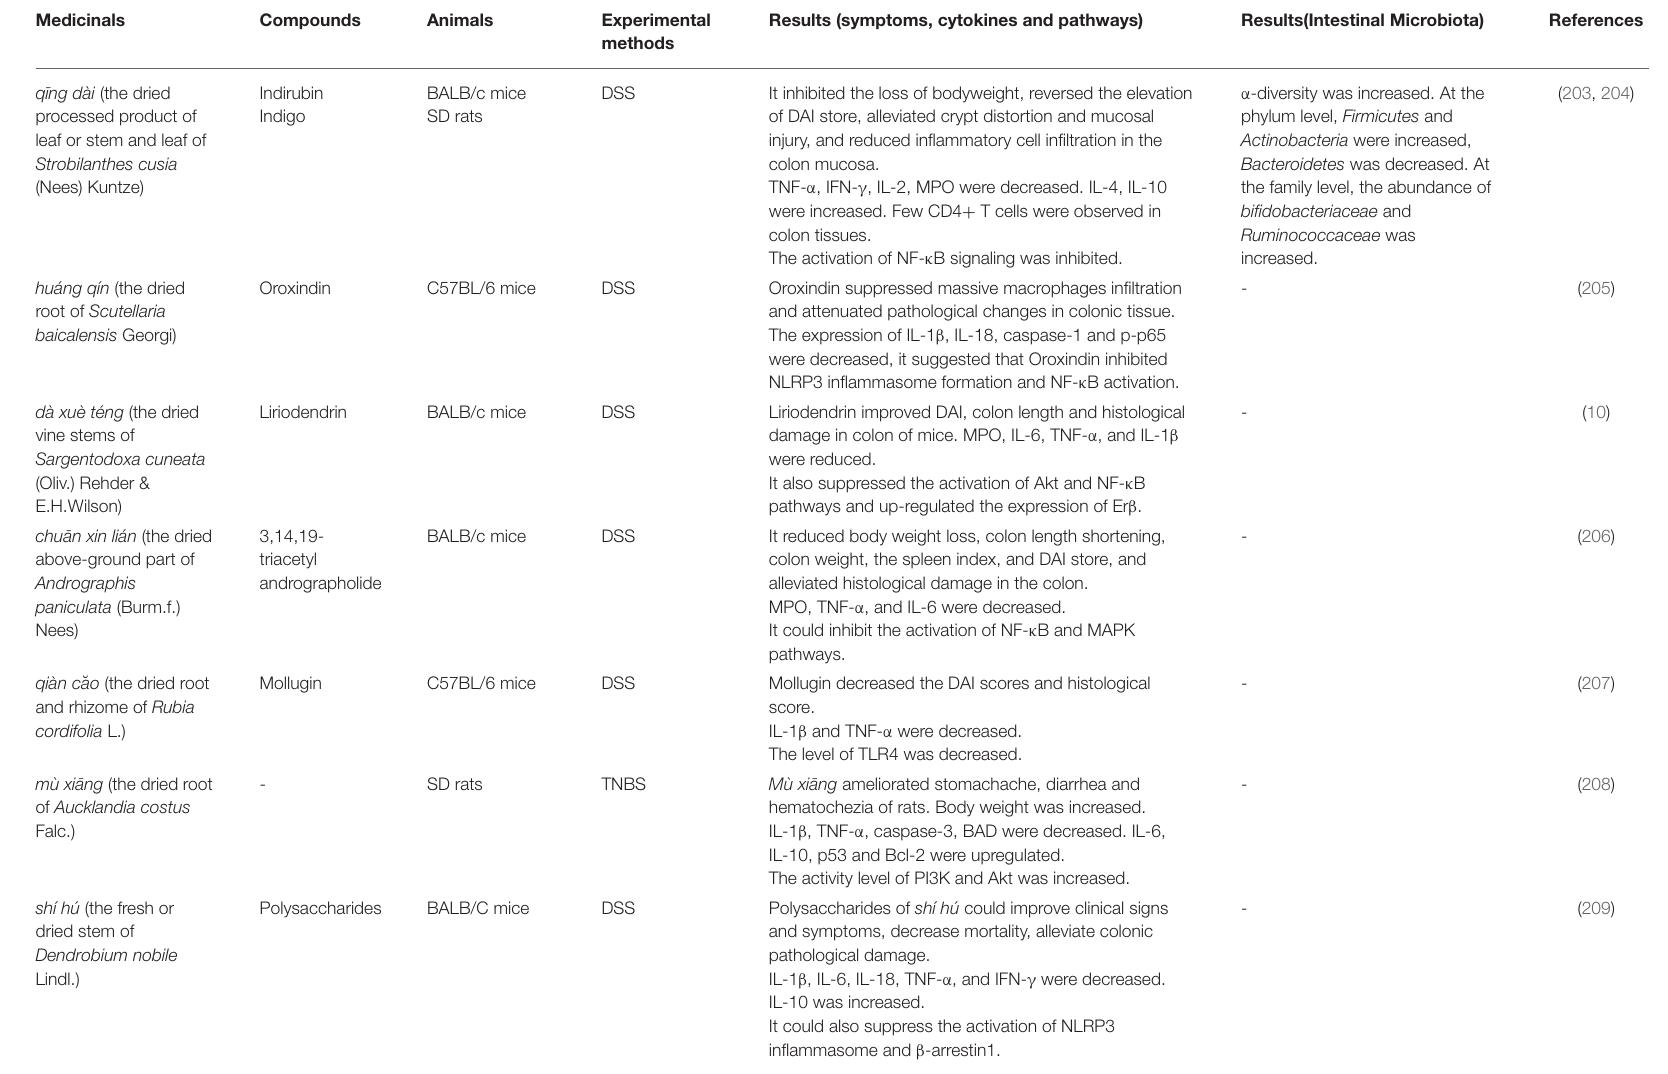
TABLE 5 | Application of compound extracted from Chinese medicinal (or single medicinals) in animal models of